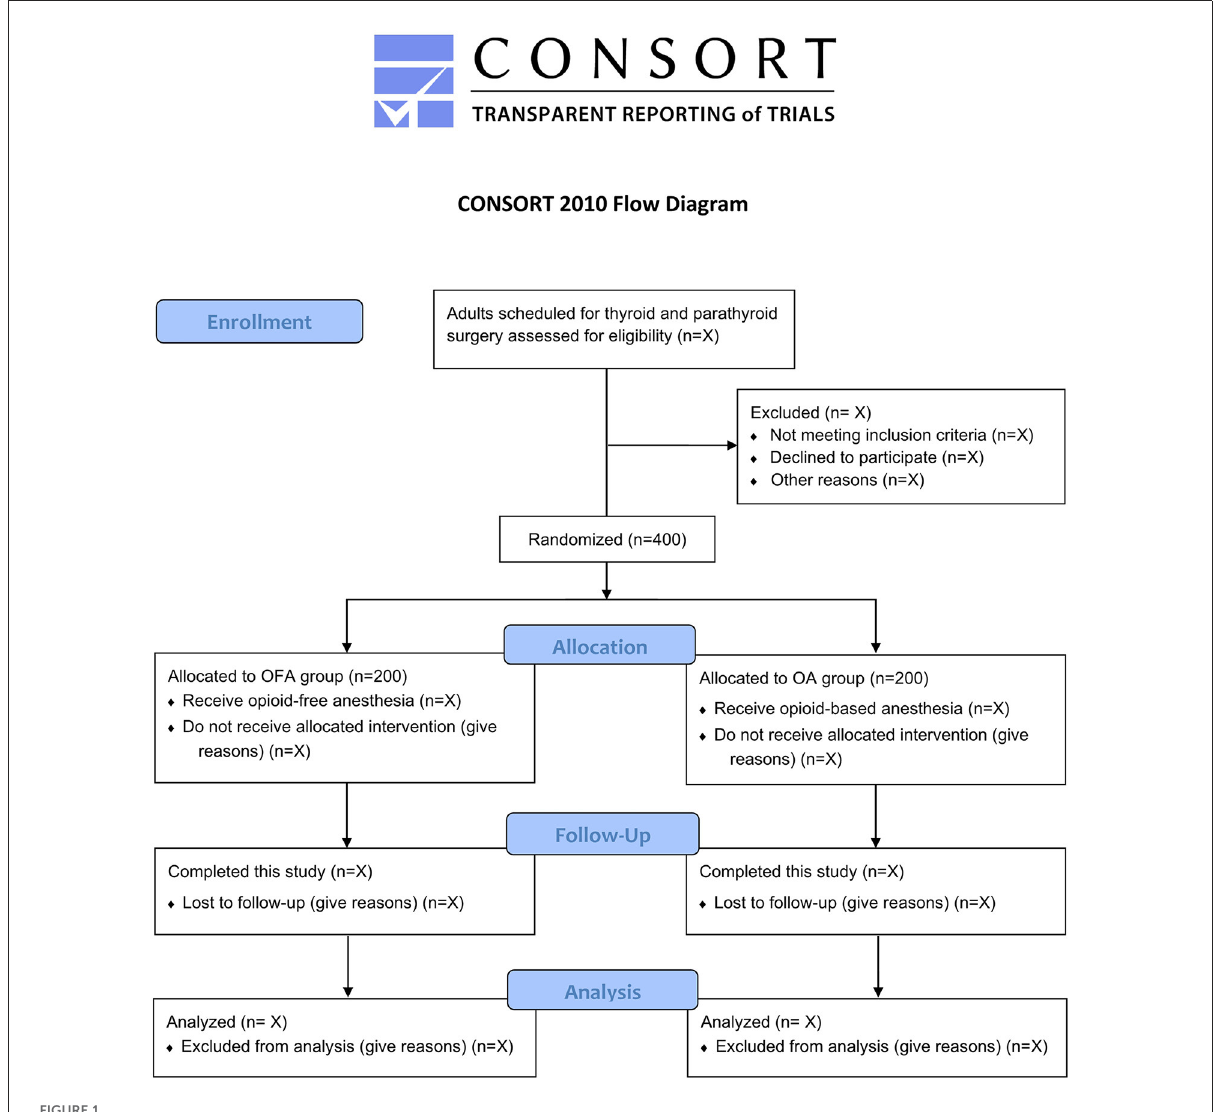
FIGURE1 Study flow